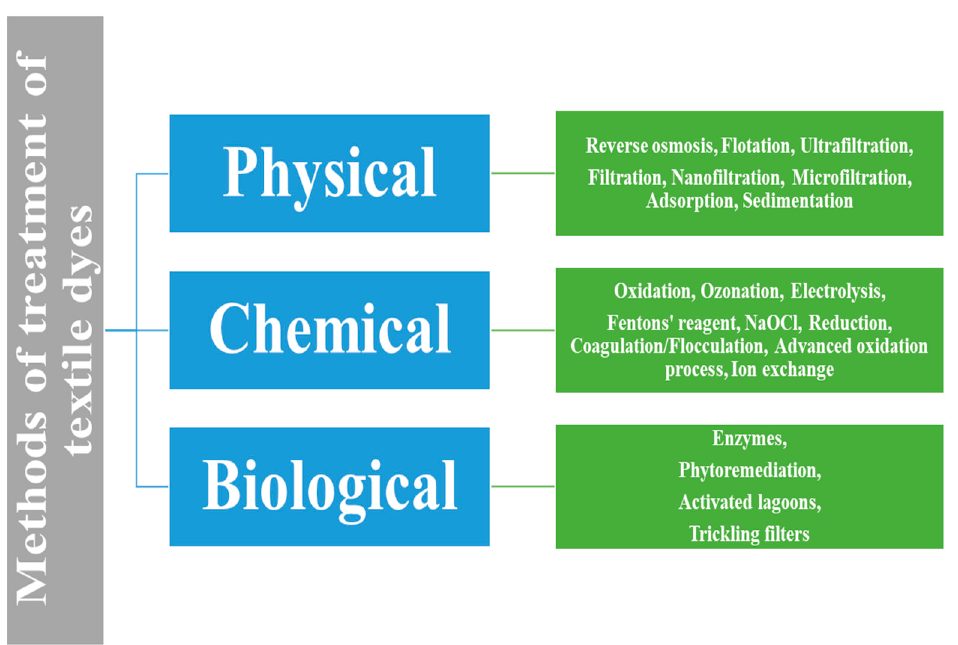
Figure 3. Various methods of treatment of textile dyes.